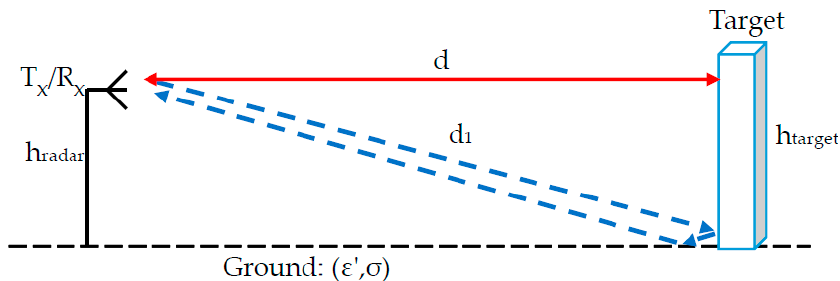
Figure 3. Two main radar propagation paths from flat target close to ground.